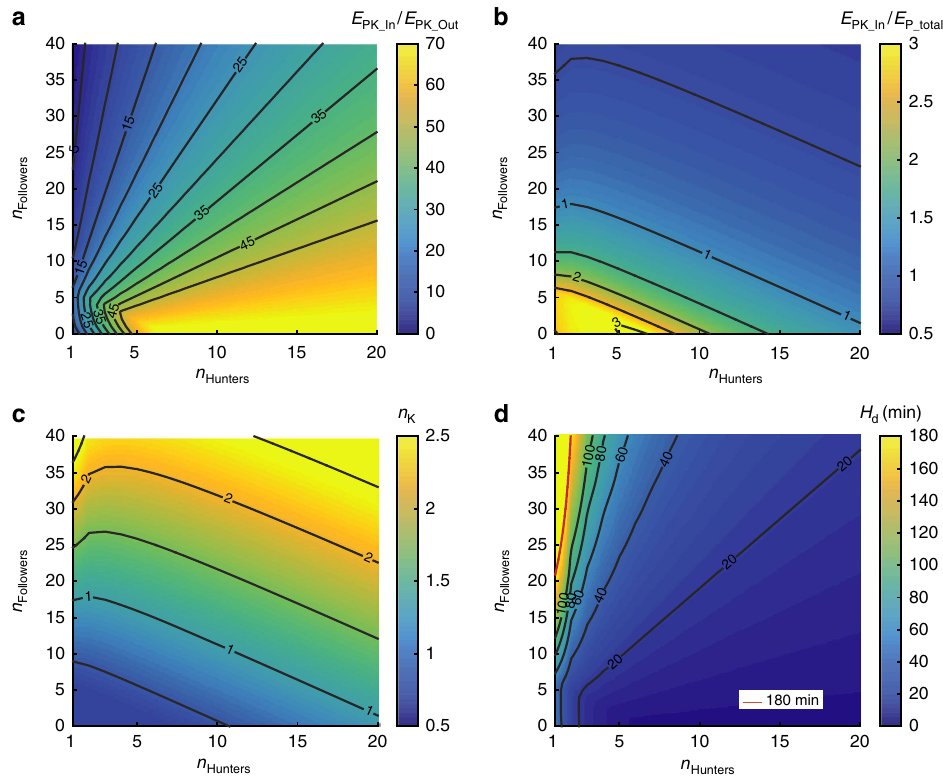
Figure 8 | Energy model outcome for African wild dogs. ( a ) Maximum pack energy gain per kill ( E PK_In ) divided by pack energy expenditure per kill ( E PK_Out ) for different pack sizes and compositions (40kg impala, 3.5kg dog stomach capacity). ( b ) Maximum pack energy gain per kill ( E PK_In ) divided by total daily pack energy expenditure including one kill ( E P_total ) for different pack sizes and compositions (sustainability line at 1). ( c ) Number of kills necessary to fulfil daily energy requirement of pack (basal metabolic cost þ ranging cost þ x times kill cost). ( d ) Total daily hunting time based on number of kills required; based on kill rate and time between hunts (22.58min), red line indicated 3h daily hunting boundary.